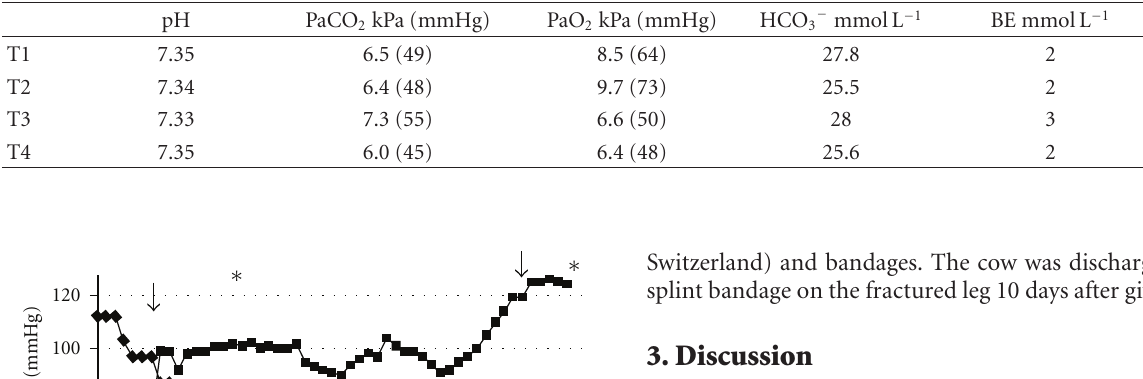
Table 1: Arterial blood samples from a late-term gravid cow undergoing metacarpal fracture repair. The first sample (T1) corresponds to 1h after induction of anaesthesia; T2, T3, and T4 to successive hours.